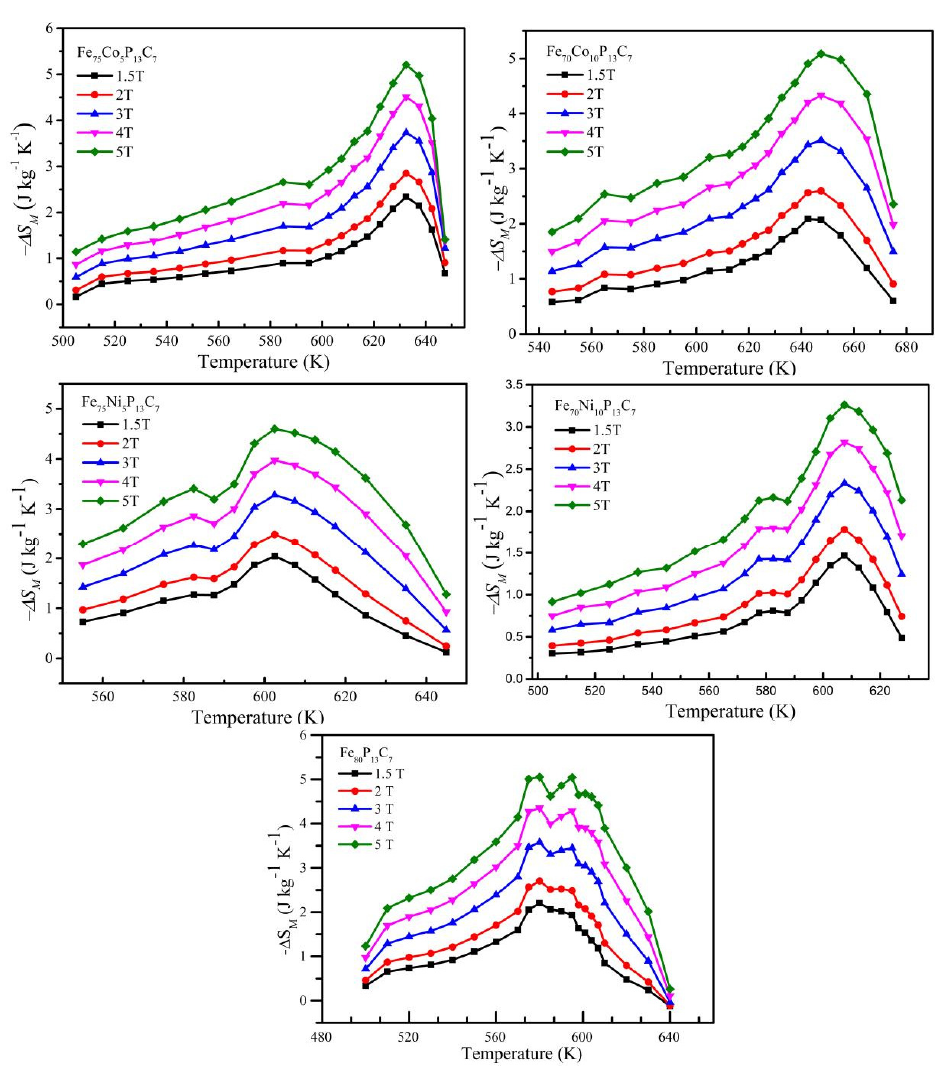
Figure 6. Magnetic entropy changes as a function of temperature under 1.5–5 T for Fe 80-x M x P 13 C 7 (M = Co, Ni; x = 0, 5 and 10 at.%) glassy alloy rods.